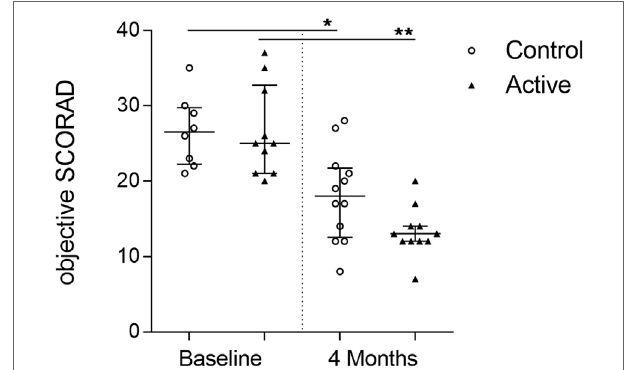
FigUre 2 | Reduction of atopic dermatitis severity over time. Individual oSCORAD of the control (open dots) and active (closed triangles) groups at baseline and after 4 months of dietary intervention, for infants from which serum samples were available ( n = 41). Line represents median ± interquartile range. Significant differences within the groups are depicted with asterisks (non-paired W-test, * p < 0.05, ** p < 0.01).